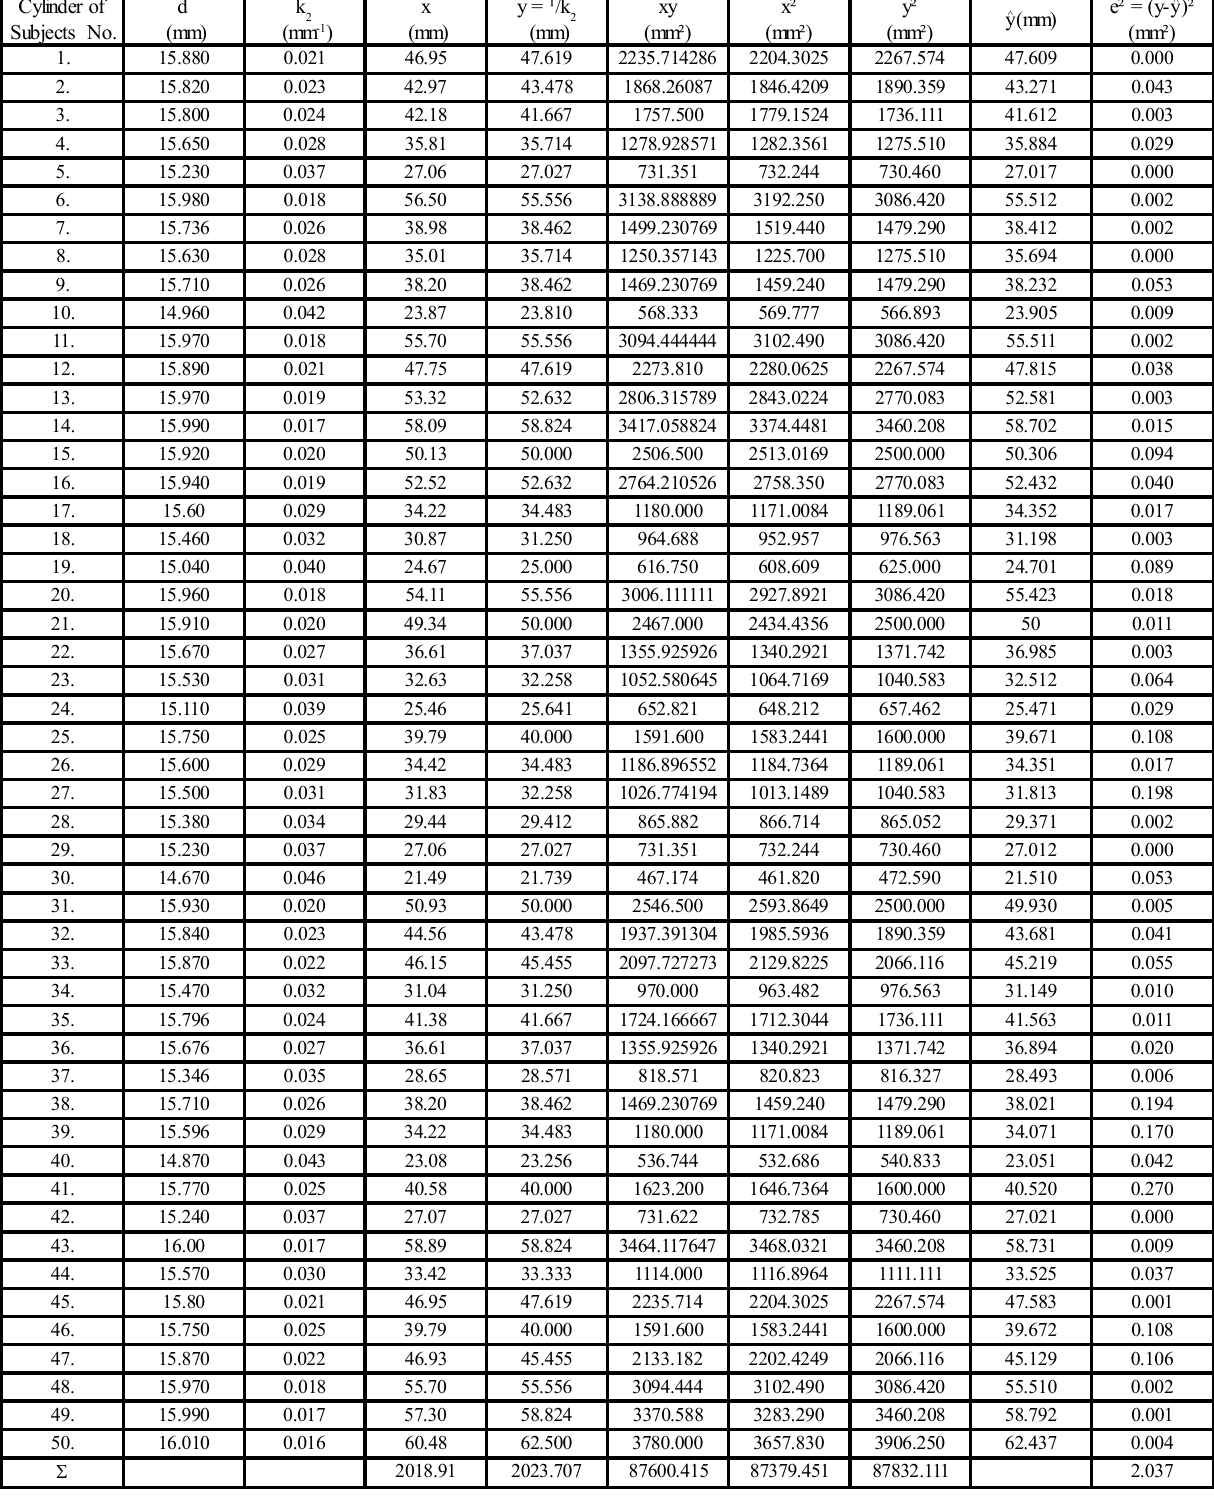
TABLE 2. STATISTICAL ANALYSIS FOR VERTICAL CURVATURE FOR THE BODY